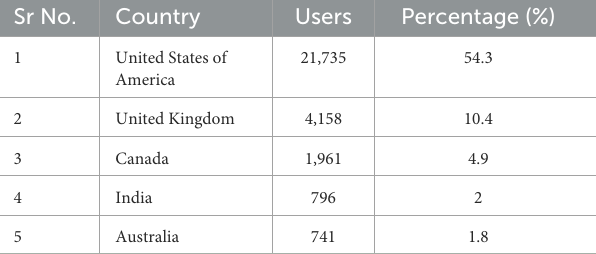
and then normalized on a scale of 0 to 100. This final number is TABLE 1 Regional popularity of #PsychTwitter.